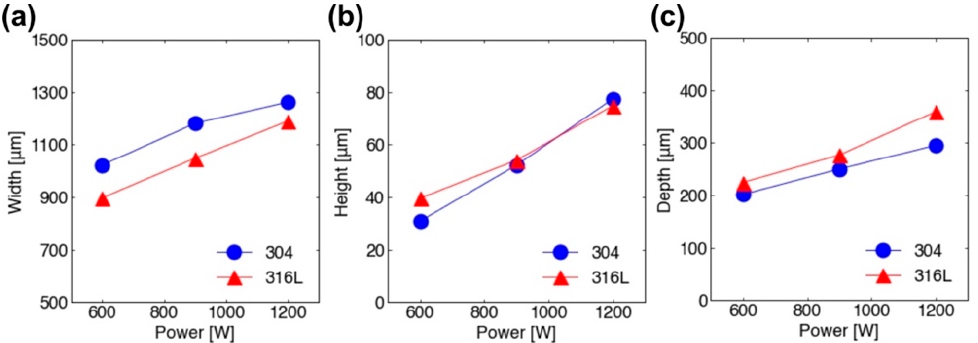
Figure 3. ( a ) Width, ( b ) height, and ( c ) depth of melt tracks formed on 316L and 304 SSs as a function of beam power. The width and the height were measured by laser microscope and the depths were measured by cross-sectional SEM observation.